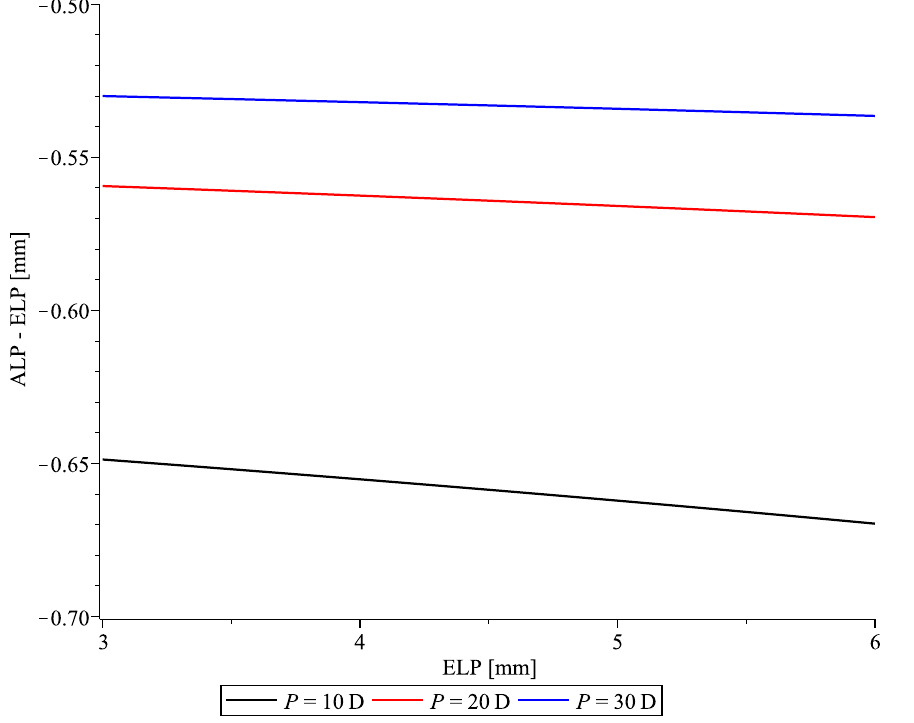
Fig 5. The difference between the anterior intraocular lens (IOL) vertex and the effective lens position (ELP) of the thin lens equivalent as a function of ELP for IOLs with optical power P = 10 D, 20 D, 30 D.